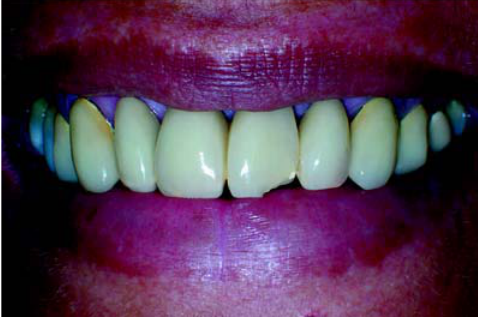
FIGURE 1- Initial aspect of the case with a fracture in the distal angle of the maxillary left central incisor. No ceramic fragment was